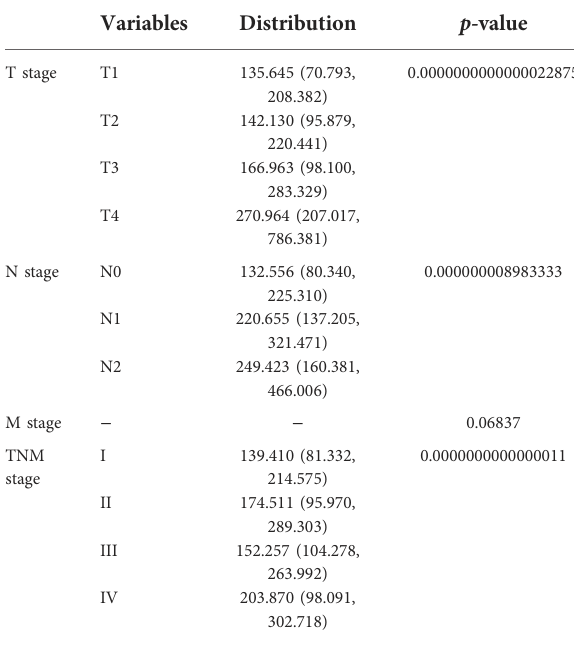
TABLE 3C Kruskal-Wallis test for T, N, M and TNM stage.